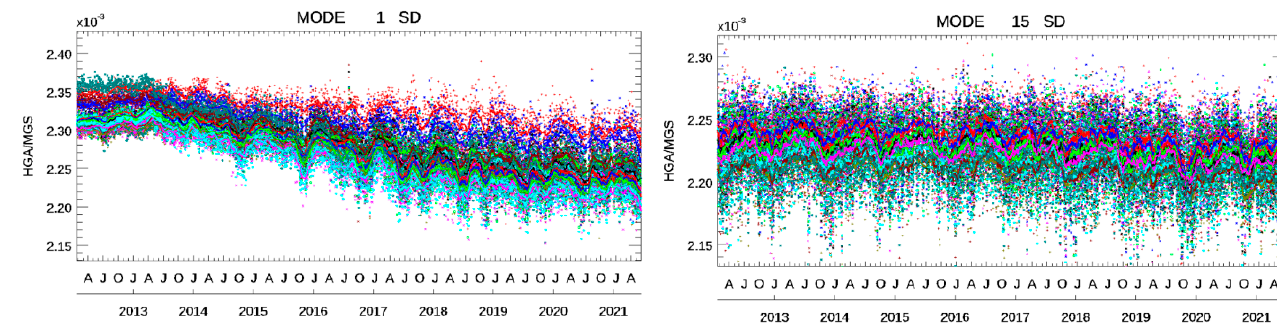
Figure 5. Ratio trend of DNB high-to-middle using SD dn signals at two aggregation modes (mode-1 and mode-15). Different colors are used to plot the DNB 16 detectors.